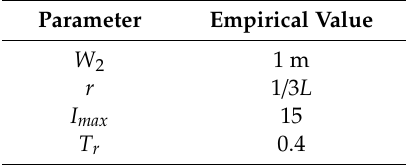
Table 3. The empirical values of parameters involved in the internal structure